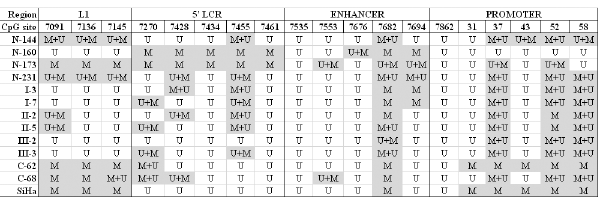
Fig 2. HPV16 methylation status of 19 CpG sites in different regions of the viral genome. N, normal cytology; I, LSIL/CIN1 diagnosis; II, LSIL/CIN2 diagnosis; III, HSIL/CIN3 diagnosis; CC, cervical cancer; SiHa, cervical cancer cell line; M, methylated; U, unmethylated; M+U, methylated and unmethylated with predominantly methylated DNA; U+M, methylated and unmethylated with predominantly unmethylated